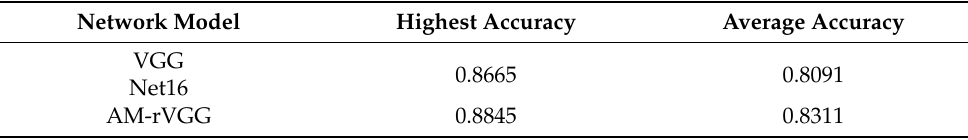
Figure 6. Comparison curve of the network training accuracy. Table 3. Comparison of the accuracy between AM ‐ rVGG and VGGNet16.